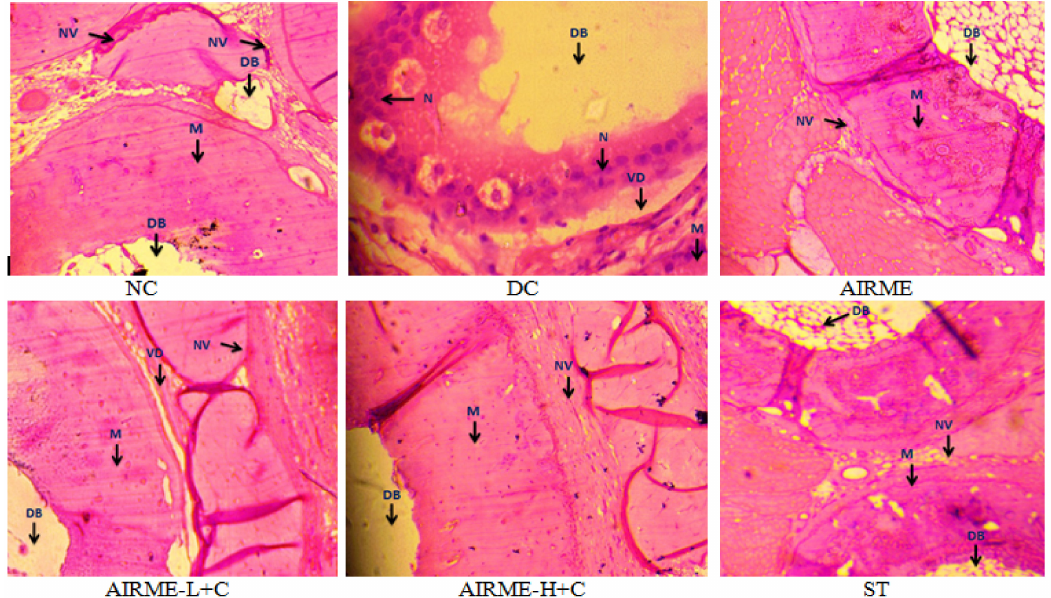
Figure 4. Histopathological study of inflamed paw tissue treated with AIRME. Paw tissue in NC and AIRME groups showed normal appearance of muscle (M) around the decalcified bone (DB), no vascular dilation (NV) and no